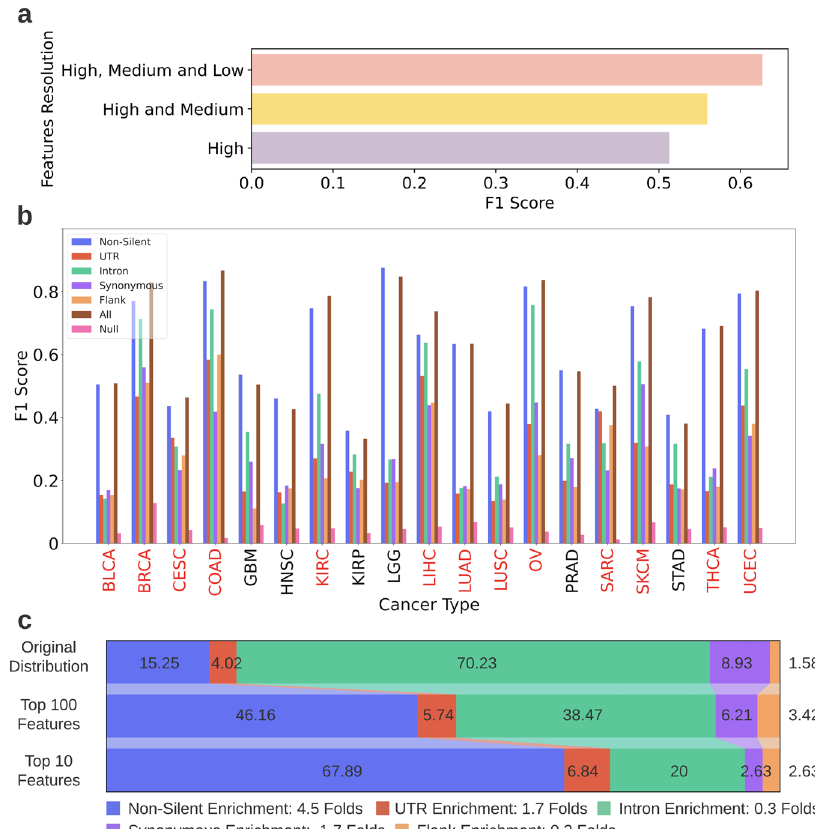
Fig. 4 Classi fi cation task results. a The F1 scores achieved in the cancer type classi fi cation task when using only high-resolution features, high and medium-resolution features and all resolutions combined. The scores shown are the average F1 scores achieved by all features models across all cancer types. b The F1 scores achieved by the OVA models per cancer type, using features from all levels of resolution. The x - axis depicts the cancer types, the y-axis depicts the F1 scores achieved by the models. Each bar color denotes a different dataset. Cancer types for which the all features model outperformed the non-silent model are denoted in red. See Fig. 1e for the unabbreviated names of the cancer types. c Feature-type distribution of the all features dataset and of the top ranked features chosen in the classi fi cation task. Feature-type distribution of the all features dataset* (top row), top ranked 100 features (middle row) and top ranked 10 features (bottom row). The feature rankings were obtained from all features models classifying the 19 cancer types and were averaged across them. The legend (below the image) indicates the enrichment in the amount of each feature-type in the top 10 features compared to its original amount in the all features dataset (ratio between bottom and top row). *Note: The distribution depicted in the top row is the distribution of the all features dataset after it underwent preprocessing relevant for the classi fi cation